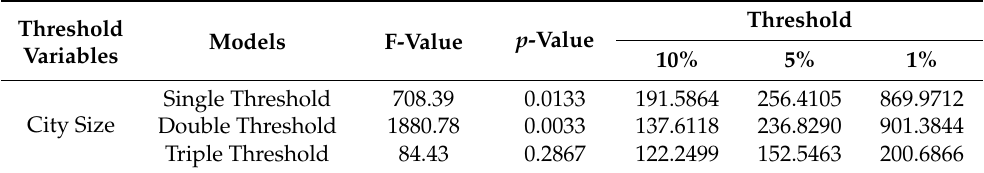
Table 5. Results of the self-sampling test for the threshold effect.